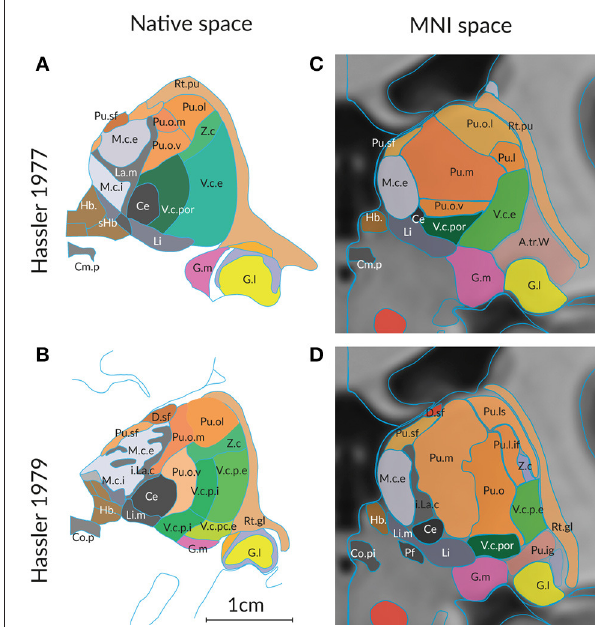
FIGURE 2 | Differences in the structural organization of the thalamus of a “normal” (A,C) and a compromised thalamus (B,D) analyzed by the same author. Parcellation of the thalamus of a 57 year old male without pathologic change in the brain ( Hassler, 1977) and of a person with the diagnosis of Parkinson’s disease (Hassler et al., 1979). (A,B) Representiation of a coronal section through the posterior commissure as originally published (cf. Figure 1 ). The scale bar was taken from the original figures; color was added. (C,D) Display of the profiles generated from the 3D reconstruction of the serial sections from both cases. The individual 3D volume was registered into the standard space (using the MNI/ICBM co-registered 3D-AHB model) and a coronal section is presented that passes through the posterior commissure. Color code as in Figure 1 . For abbreviations see Supplementary Table 5